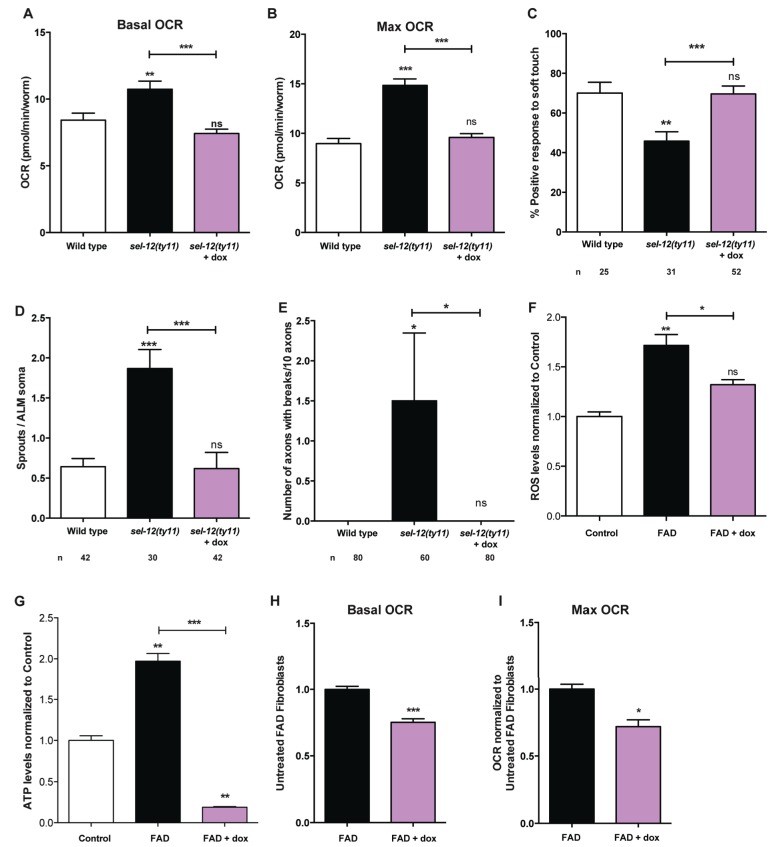
Reducing mitochondrial activity using doxycyline alleviates neurodegenerative phenotypes observed in sel-12 mutants.(A) Basal and (B) maximal respiration rates of wild type and sel-12 mutant animals treated with doxycycline (dox). (C) Quantification of the response of dox treated day one sel-12(ty11) animals to light anterior and posterior touch. (D) Quantification of aberrant structures (sprouts/branches) on ALM neuronal soma and (E) frequency of breaks in ALM and PLM neuronal processes at day 1 of adulthood in response to dox. (F) ROS and (G) ATP levels normalized to protein content in skin fibroblasts isolated from control and FAD patients treated with dox. (H) Basal and (B) maximal respiration rates in skin fibroblasts isolated from control and FAD patients treated with dox. n = number of animals analyzed per genotype. Data are displayed as mean ± SEM, and all comparisons have been made to wild type animals unless otherwise indicated. ns p>0.05, *p<0.05, **p<0.001, ***p<0.0001 (One way ANOVA with Tukey test for A-G, two-tailed T-test for H and I).10.7554/eLife.33052.033Figure 8—source data 1.Raw data for Figure 8.